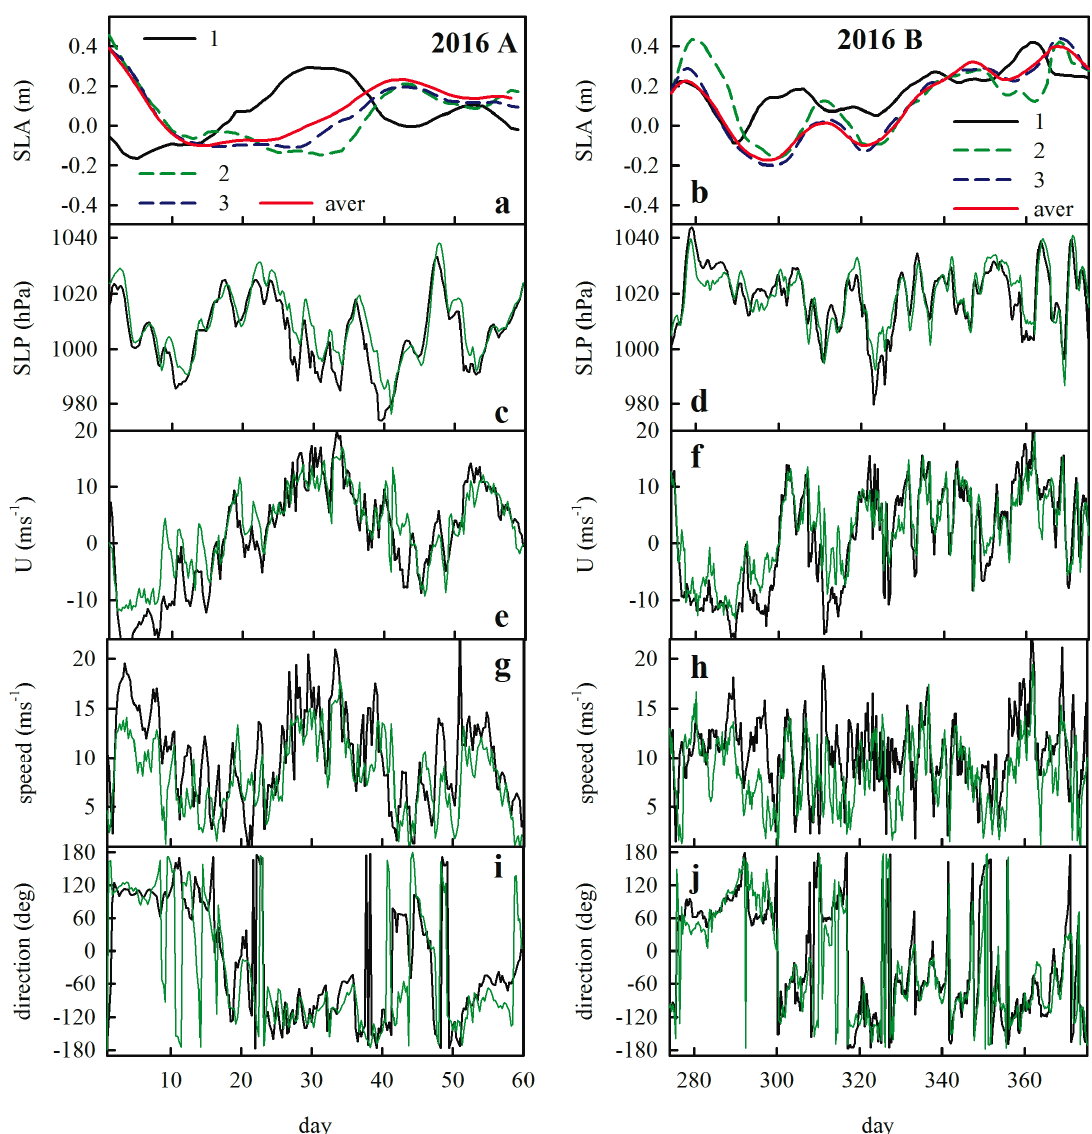
Figure 7. The same as in Figure 5, but data are presented for MBI in 2016 (column on the left side) and for the barotropic inflow in the fall/winter of 2016 (column on the right side). This event was not classified as the MBI in the IOW reports.